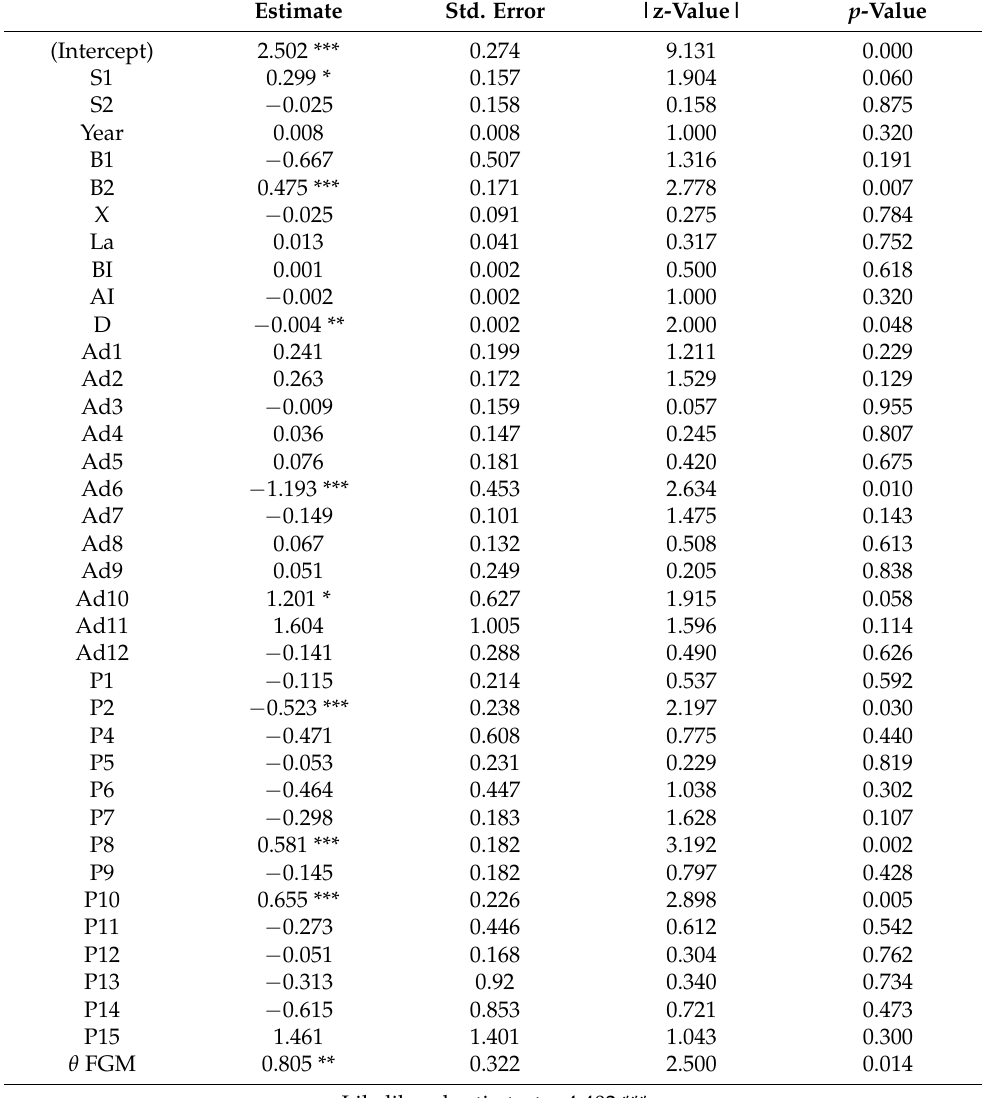
Table 5. Estimation results of the time-to-event equation of the failed